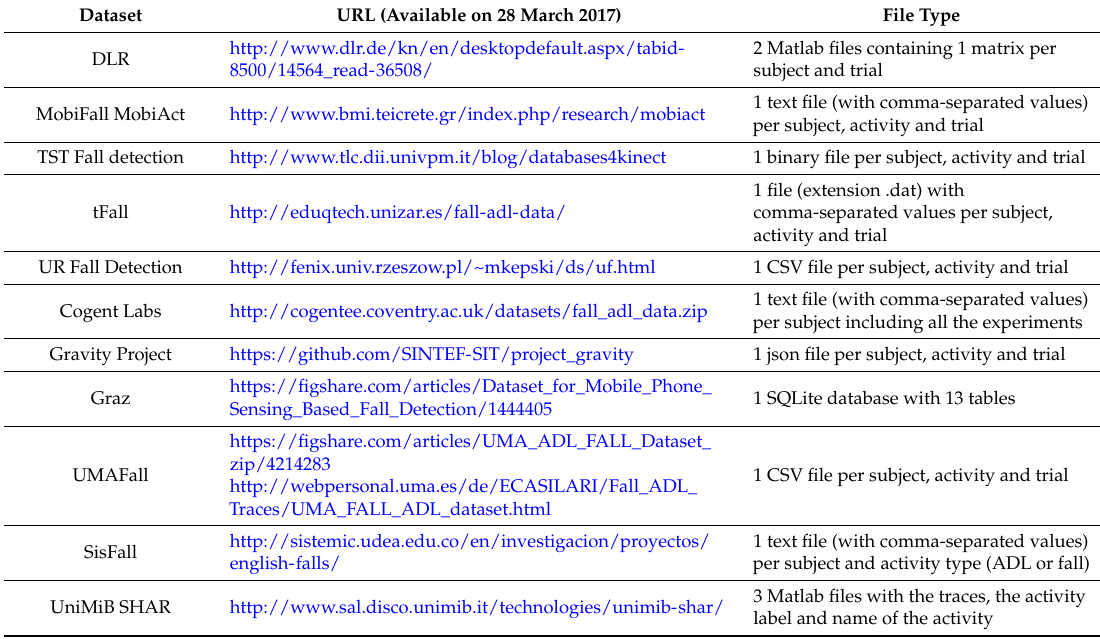
Table 2. URL from which the traces can be downloaded and file format of the dataset.